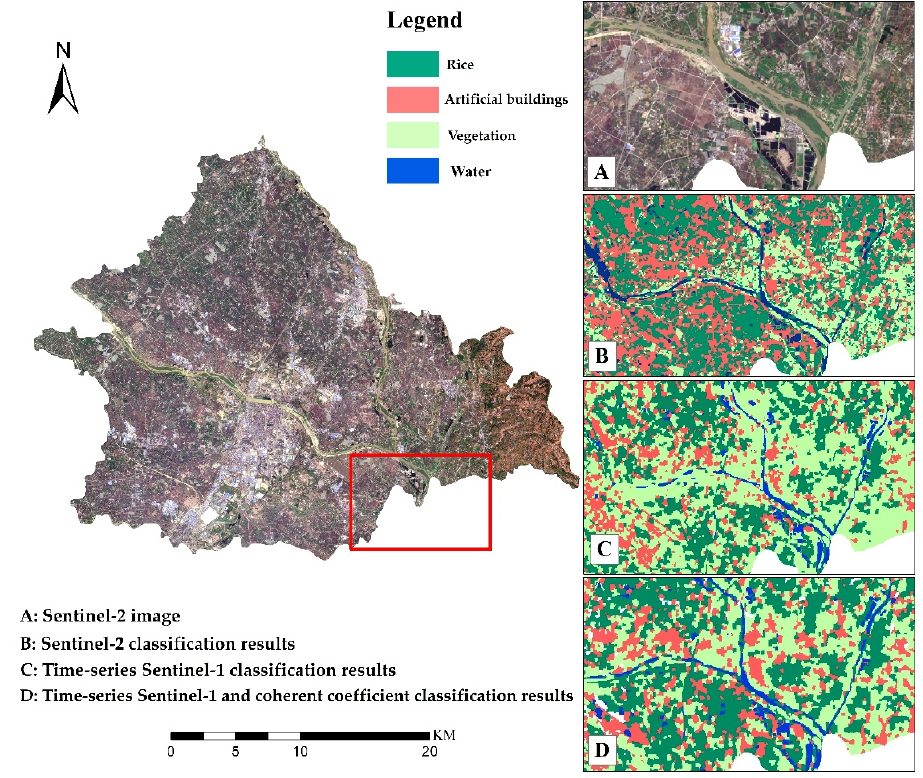
Figure 20. Local effect map of rice identification result.